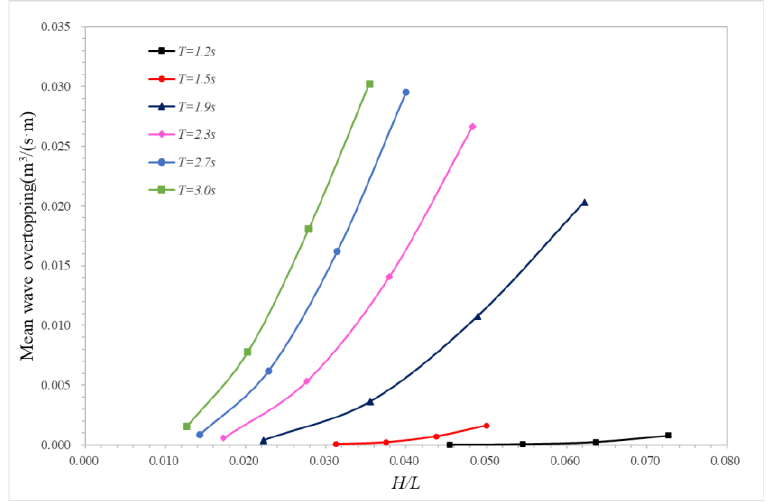
Figure 8. Wave overtopping with a certain wave period and different wave steepness.